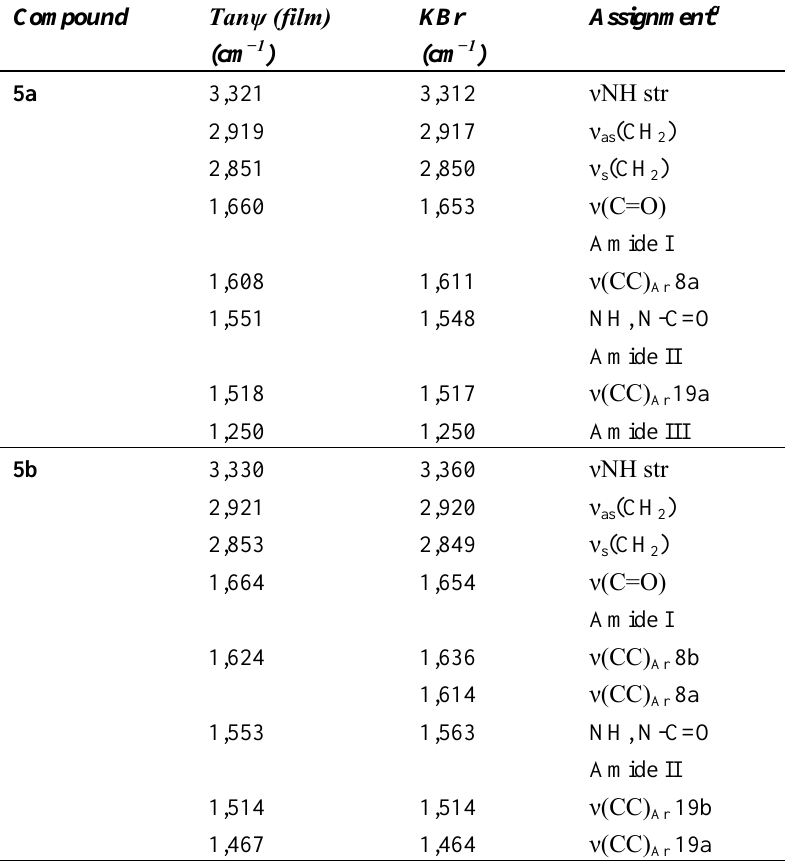
Table 1. Orientation sensitive bands observed for compounds 5a , 5b